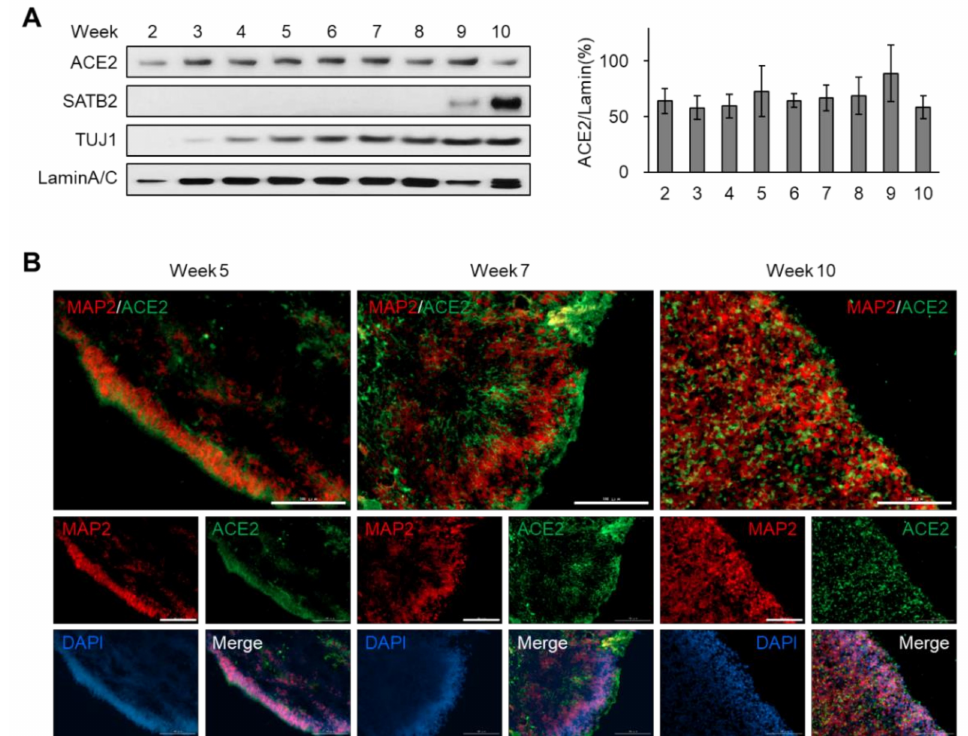
Figure 2. Sustained expression of ACE2 during the development of brain organoids. ( A ) Immunoblot analysis of dorsal forebrain organoids collected at di ff erent timepoints after di ff erentiation. The relative intensity of the ACE2 band was quantified using LaminA / C as a control. ( B ) Immunofluorescence of dorsal forebrain organoids collected at di ff erent timepoints after di ff erentiation for detecting MAP2 and ACE2. Scale bar, 100 µ